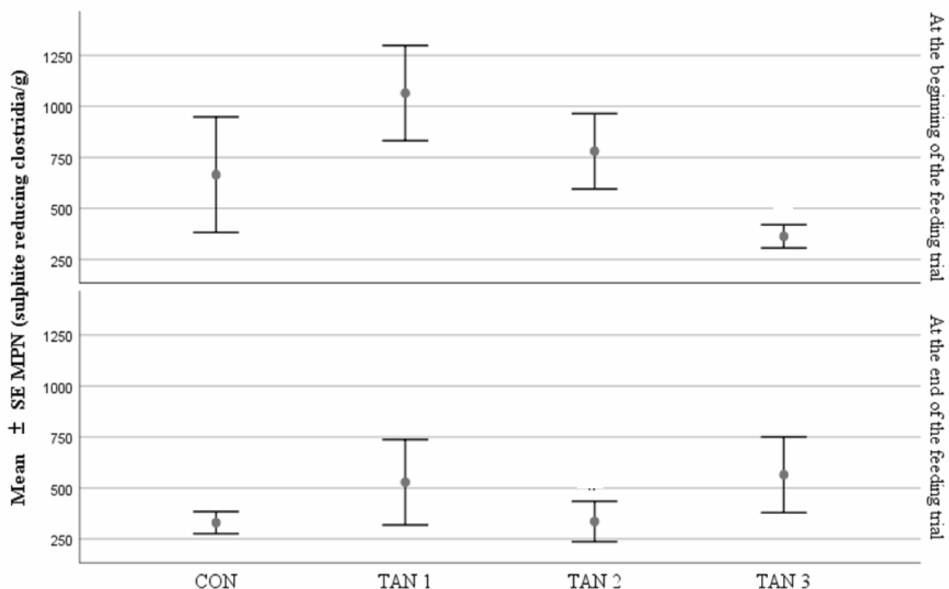
Figure 1. Total number of Clostridia in fecal samples before and after tannin supplementation determined by the most probable number method. No tannin additive in the diet (CON); 10 g of mixture (HT + soy protein additive) per animal—1.0 g kg − 1 DM (TAN 1); 15 g of HT additive per animal —1.5 g kg − 1 DM (TAN 2); and 15 g of HT additive per animal added to the TMR diet with reduced quantity of concentrate in nominal value—1.5 g kg − 1 DM (TAN